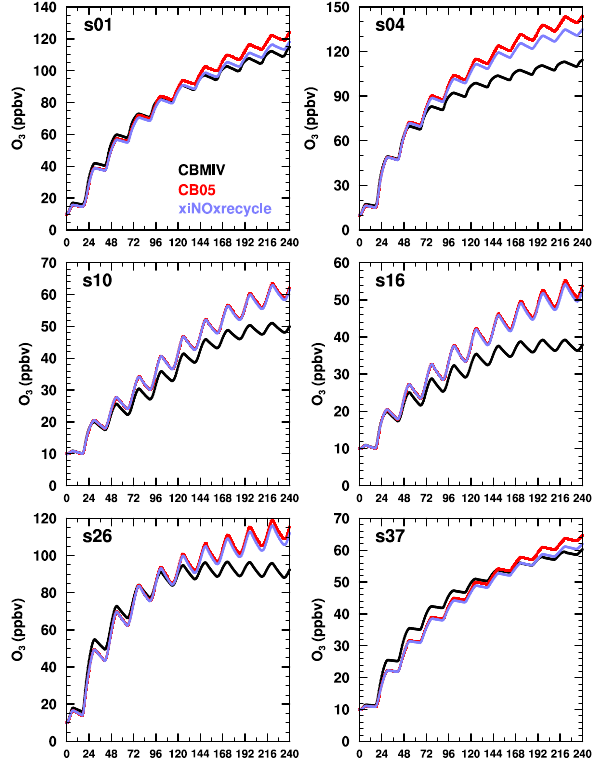
Figure 7 . Example scenario results for sensitivity test xROOH . Ozone mixing ratios (ppbv) 4 Fig. 7. Example scenario results for sensitivity test xROOH. Ozone for the base CB05 (red), base CBMIV (black) and sensitivity test xROOH (violet) over the 240 5 mixing ratios (ppbv) for the base CB05 (red), base CBMIV (black) hr simulation period. 6 7 and sensitivity test xROOH (violet) over the 240h simulation pe- riod.